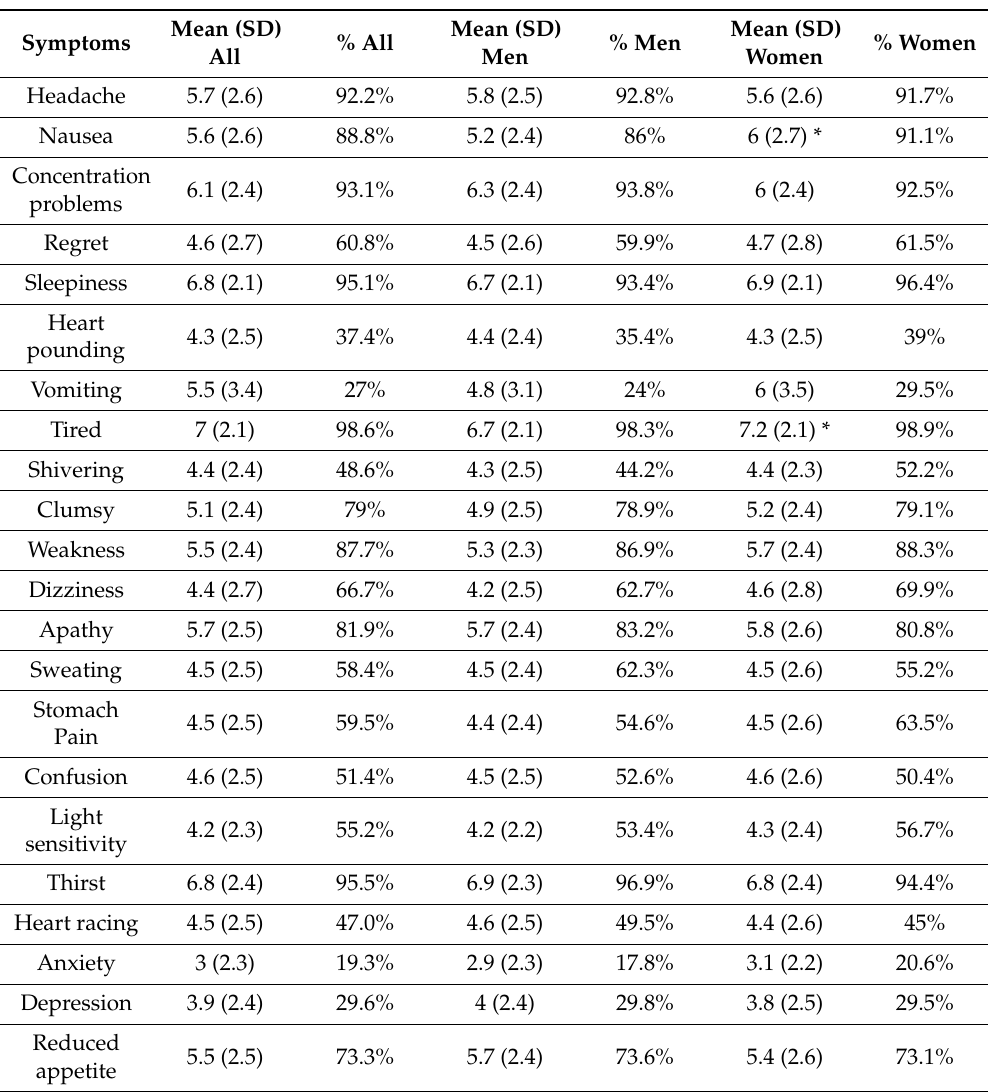
Table 6. Presence and severity of individual hangover symptoms after alcohol consumption and reaching an eBAC of 0.2% ≤ eBAC <